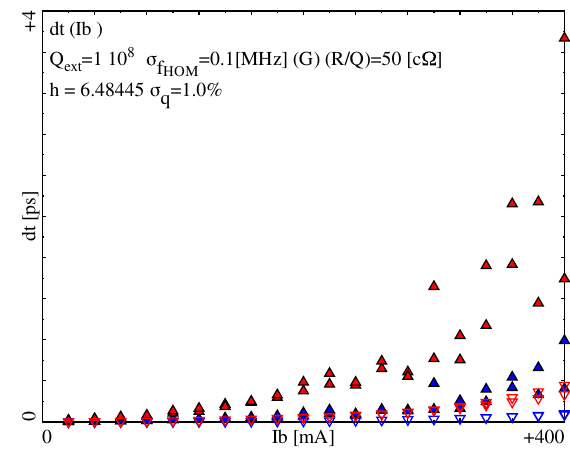
FIG. 28. (Color) dt as a function of I B for two consecutive pulses with Q ext ¼ 10 8 , (cid:1) (cid:3) f ¼ 100 kHz ; red: worst bunch in pulse; blue: rms; filled upward triangles: with 1% charge scatter; hollow downward triangles: without bunch